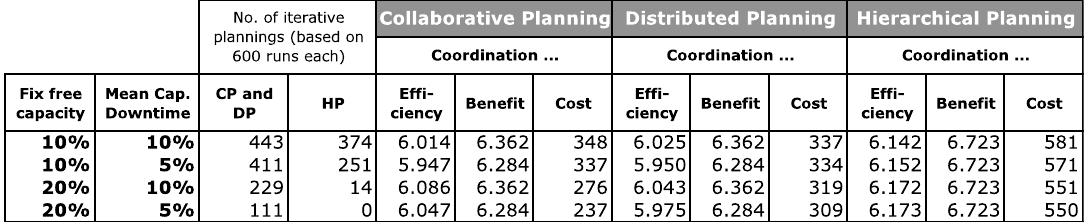
Table 1. “Simulation results [mean values in 1.000 € /